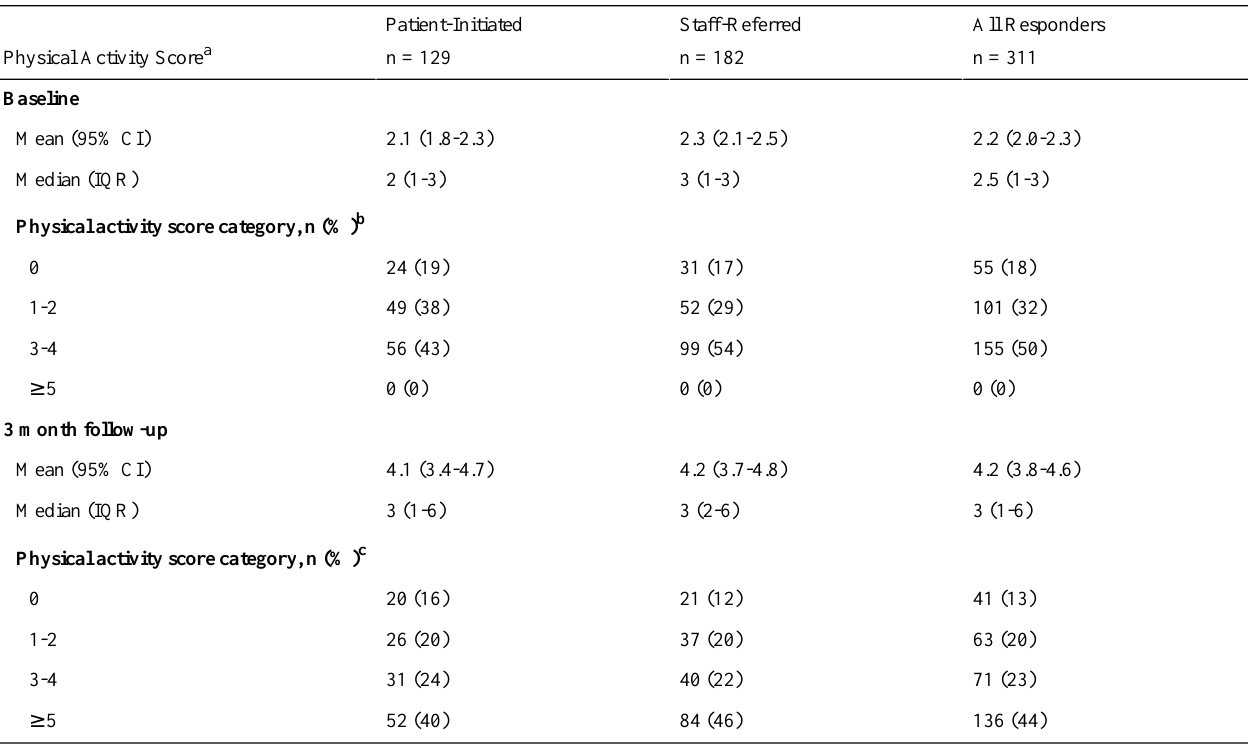
Table 3. Physical activity score and category distribution at baseline and follow-up